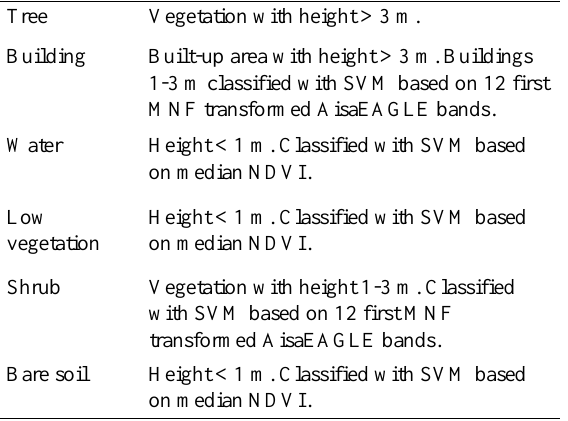
Table 2. Land cover classes at level-1.